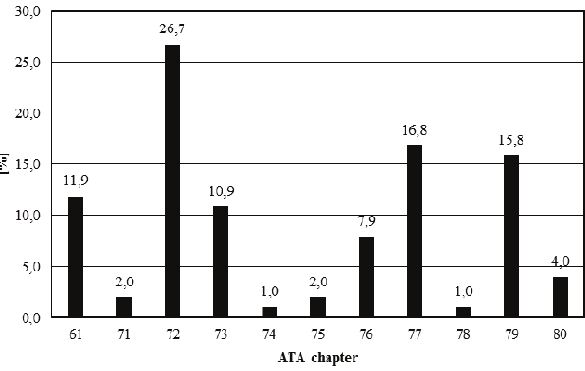
Fig. 15. Share of each powerplant system events coded in the ATA 100 chapter between 2008 and 2016